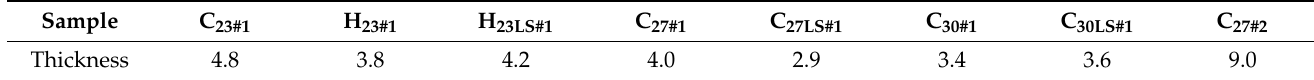
Table 4. Thickness of oxides layer [ µ m]. Standard uncertainty value 0.5 µ m.